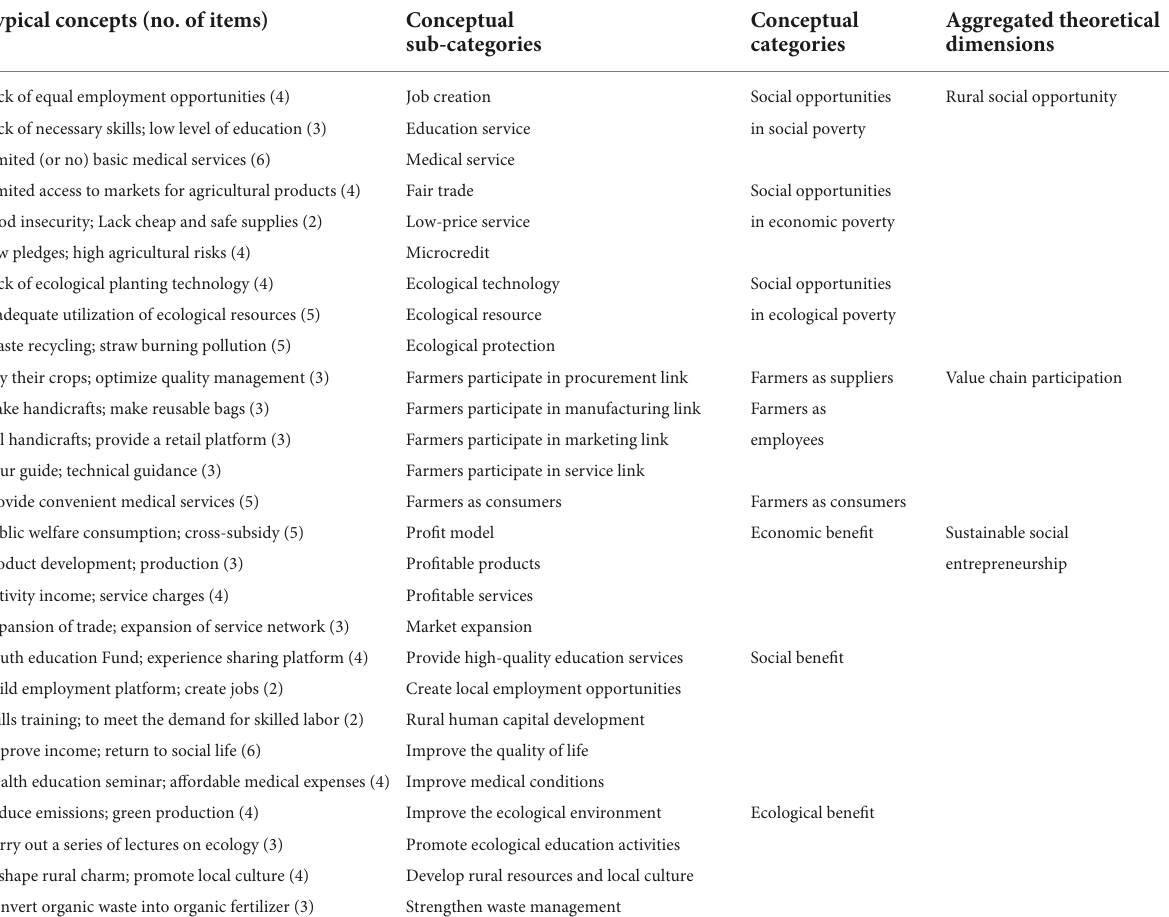
TABLE 2 Data coding and